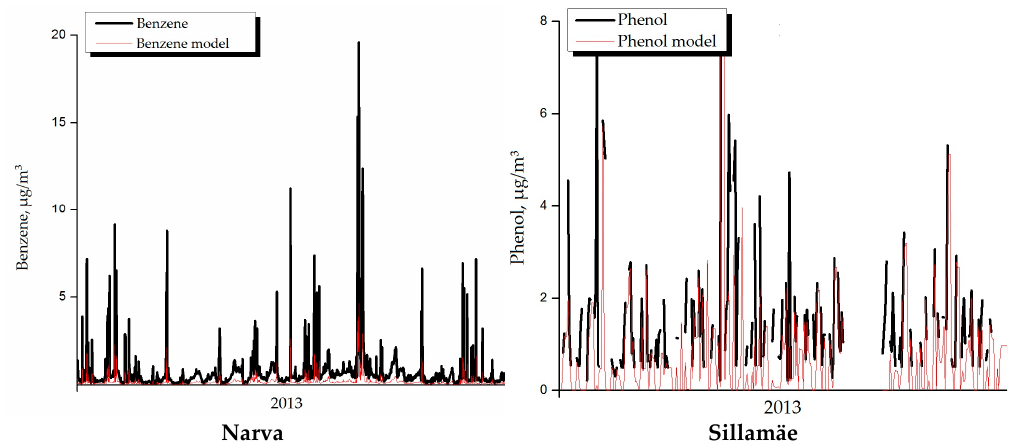
Figure A1. Measured and modelled concentrations of PM 2.5 , benzene and phenol in monitoring stations in 2013.